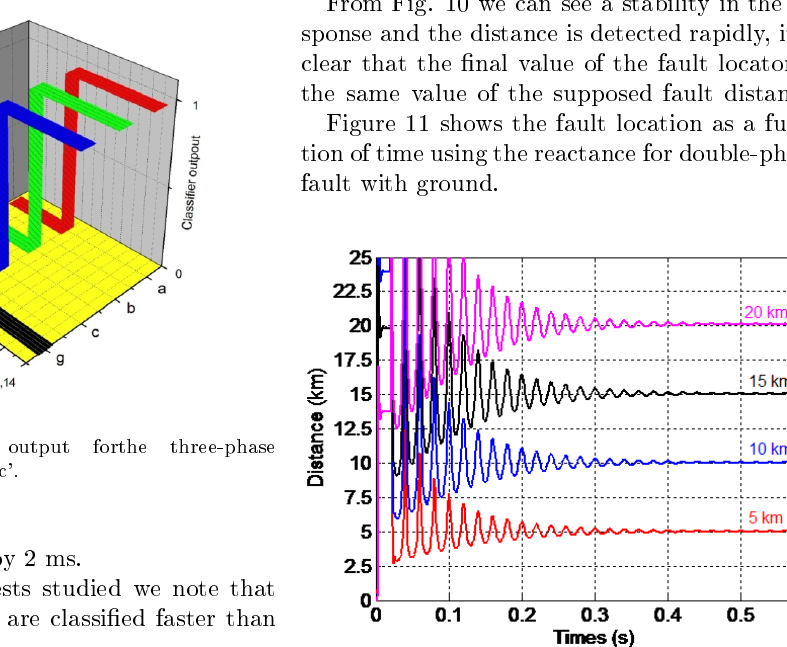
Fig. 11: Fault location as function of time using the re- actance for double-phase fault with ground.